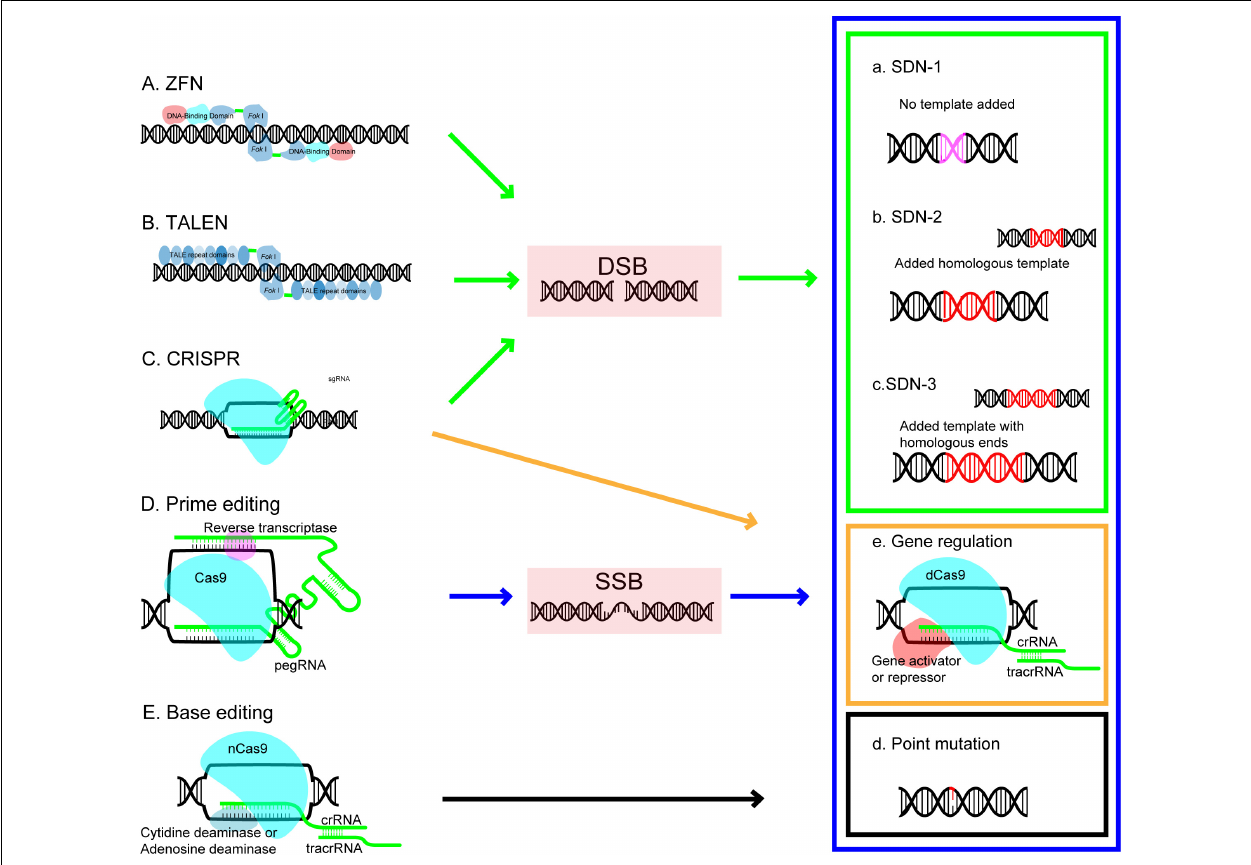
FIGURE 1 | Genome editing platforms and editing outcomes. Each editing platform (arrow) and its outcomes (rectangular) are coded with the same color. ZFN, zinc-finger nuclease; TALEN, transcription activator-like effector nuclease; CRISPR, clustered regulatory interspaced short palindromic repeat; DSB, double strand breaks; SSB, single strand breaks; Outcomes of GE created by site-directed nucleases (SDN) includes: SDN1-the approach involves DNA breaks repair through DNA repair mechanisms in the host cellular without using an added repair template; SDN2-the approach involves the break repair via HR using an added homologous repair template; and SDN3-the approach involves DNA break repair via either HDR or NHEJ pathway using an added DNA template containing nonhomologous sequences but with homologous